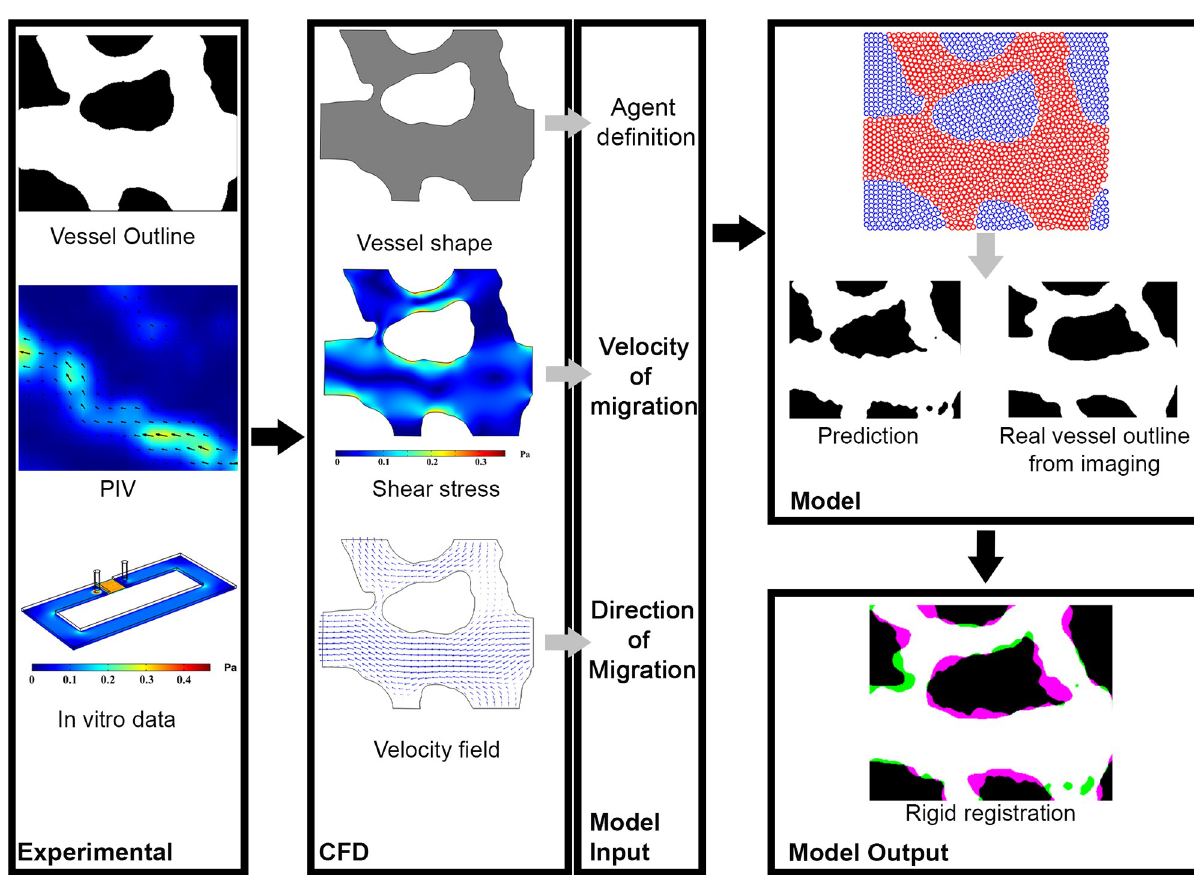
Fig 1. Flowchart of the model. Initial vessel outline and μ PIV results were used as inputs for the CFD module which gives the shear stress levels and velocity field for each point within the vasculature. Vascular and avascular agents were defined based on the vessel shape. Shear stress levels together with in vitro data for the relation between shear stress and EC migration rate were used to determine the velocity of migration of each vascular agent in each time-step. The velocity field was used to determine the direction of migration for ECs, such that the ECs migrated in the opposite direction of flow. These were used as the inputs for the computational model which predicts the final vessel shape based on the vascular agents’ final coordinates. Finally, the model prediction was compared with the real outline of the vessel after the period of prediction using rigid registration.